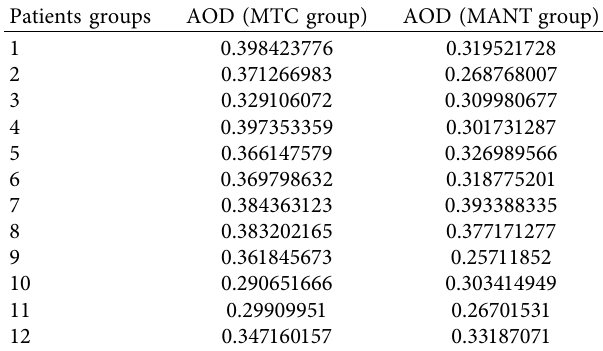
Table 1: Staining degree of target protein in paired tissues. Patients